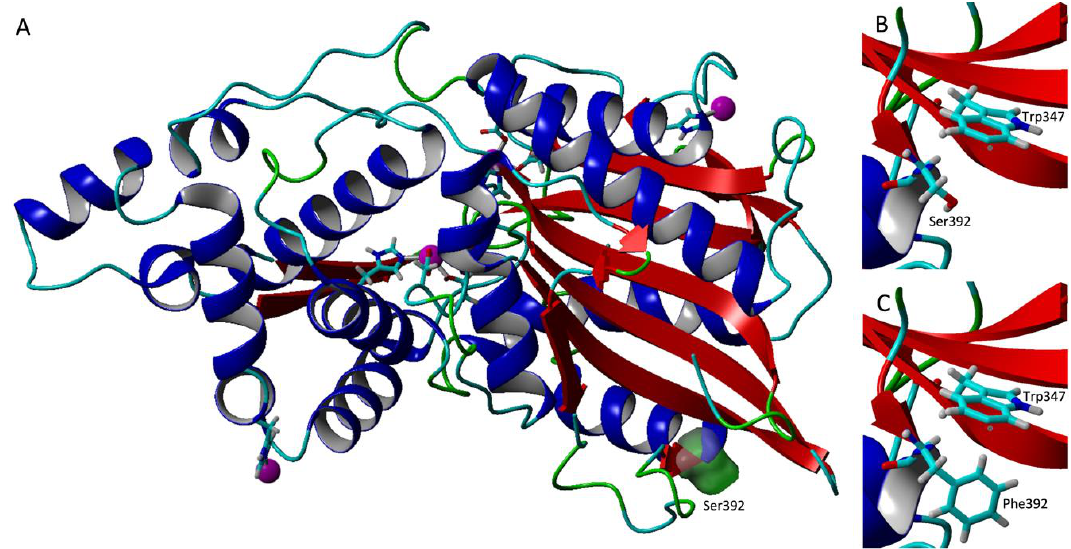
Figure 6. ( A ): Mutation site of S392. ( B ): Location of residues S392 and W347. ( C ): Substitution of S392F, which introduced two hydrophobic interactions with W347